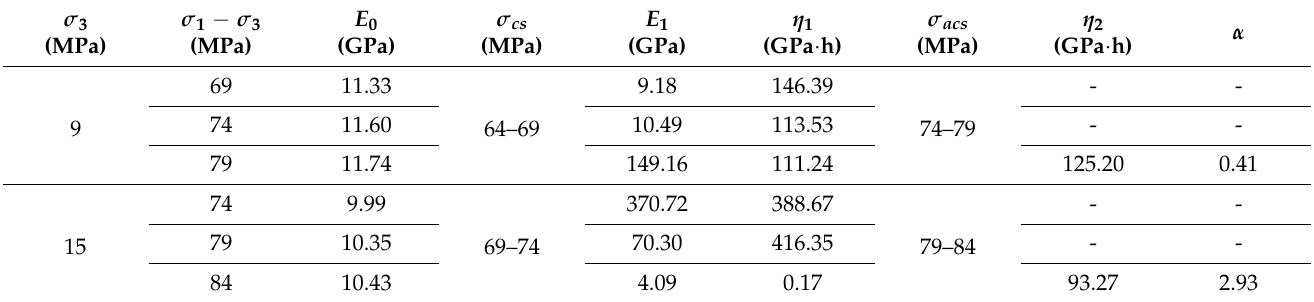
Table 3. Parameter identification results of the testing